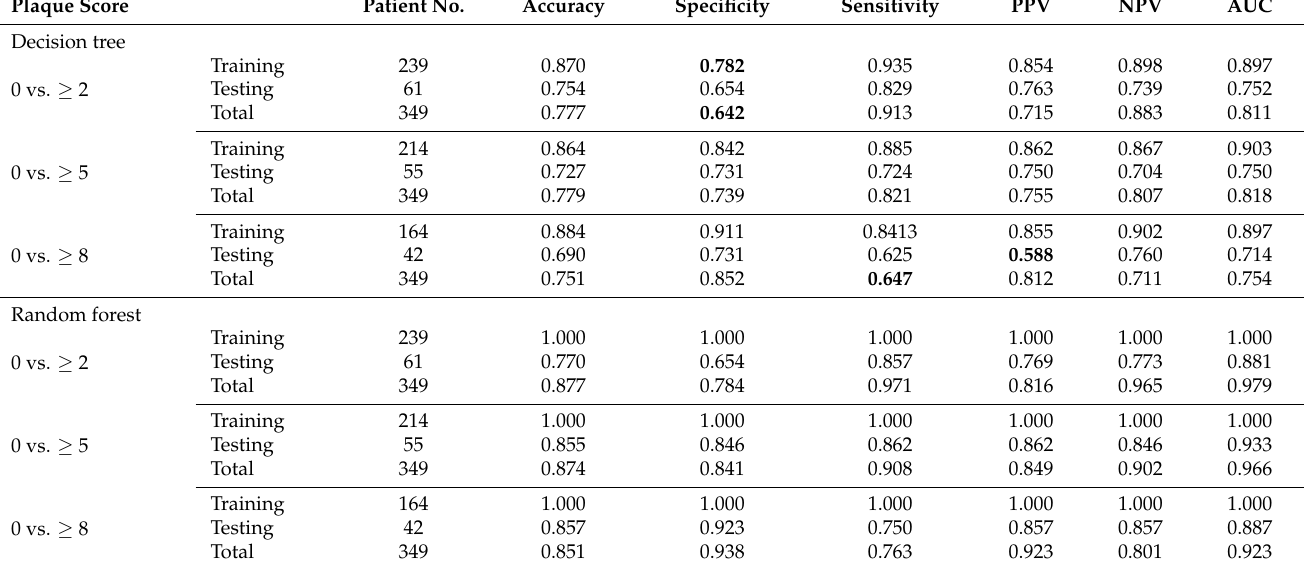
Table 2. Performance metrics of decision tree and random forest in the 3 subgroups of carotid artery stenosis patients among training, testing and total subjects.